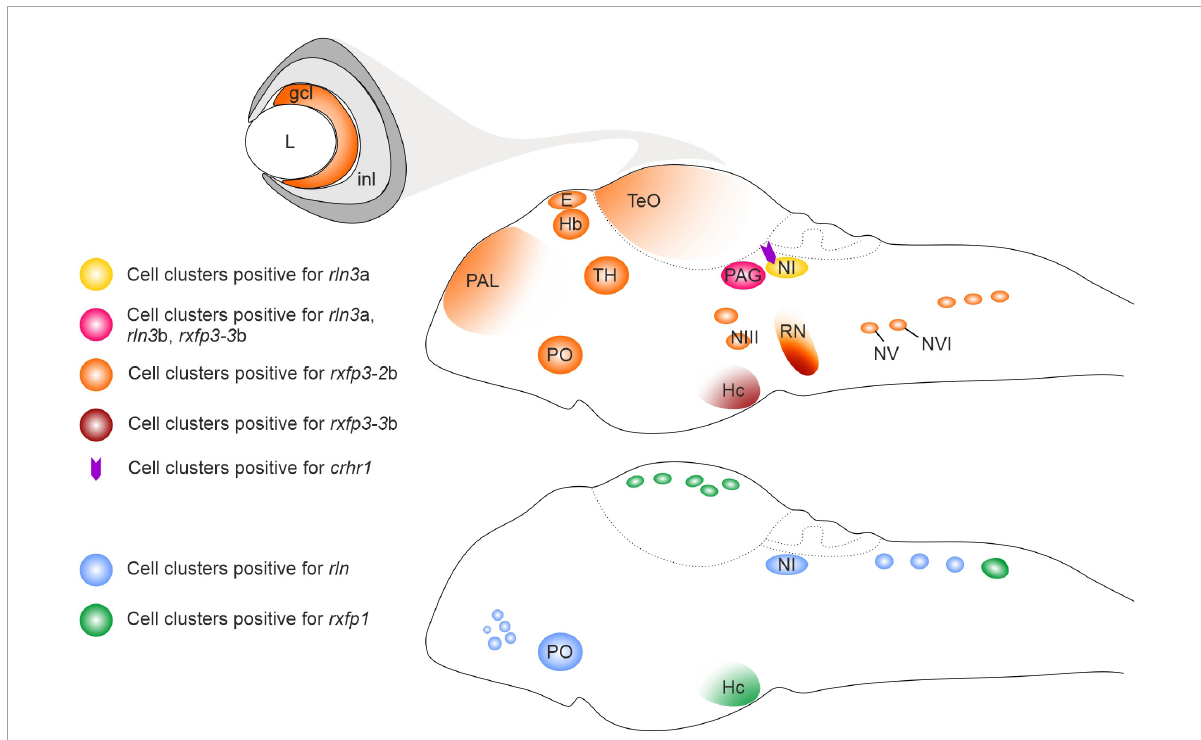
FIGURE1 Schematic illustration of relaxin ligand and receptor expression patterns in the larval zebrafish brain. crhr1, corticotropin-releasing hormone type 1 receptor gene; ccl, ganglion cell layer; E, epiphysis; Hb, habenula; Hc, caudal hypothalamus; inl, inner cell layer; L, lens; NI, nucleus incertus ; NIII, NIII cranial nerve nuclei; NV, NV cranial nerve nuclei; NVI, NVI cranial nerve nuclei; PAL, pallium; PAG, periaqueductal gray; PO, preoptic area; rln , relaxin; rln 3a, relaxin peptide 3a gene; rln 3b, relaxin peptide 3b gene; RN, raphe; rxfp1 , relaxin family peptide type 1 receptor gene; rxfp3 -2b, relaxin family peptide type 3 receptor 2b gene; rxfp3 -3b, relaxin family peptide type 3 receptor 3b gene; TeO, optic tectum; TH,